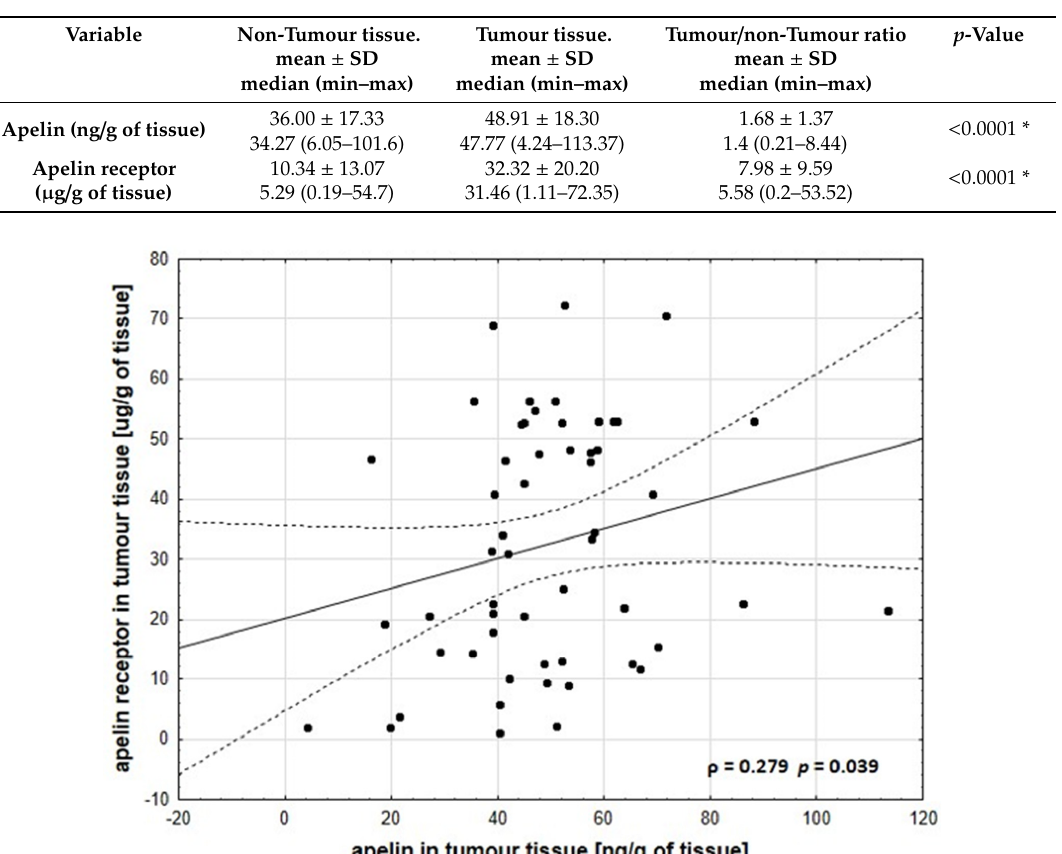
Table 3. Apelin and apelin receptor tissue level in CRC patients. Tissue level of apelin and APJ was normalized to non-tumour tissue, and analyzed using the Wilcoxon test. * Statistically significant at p < 0.05.